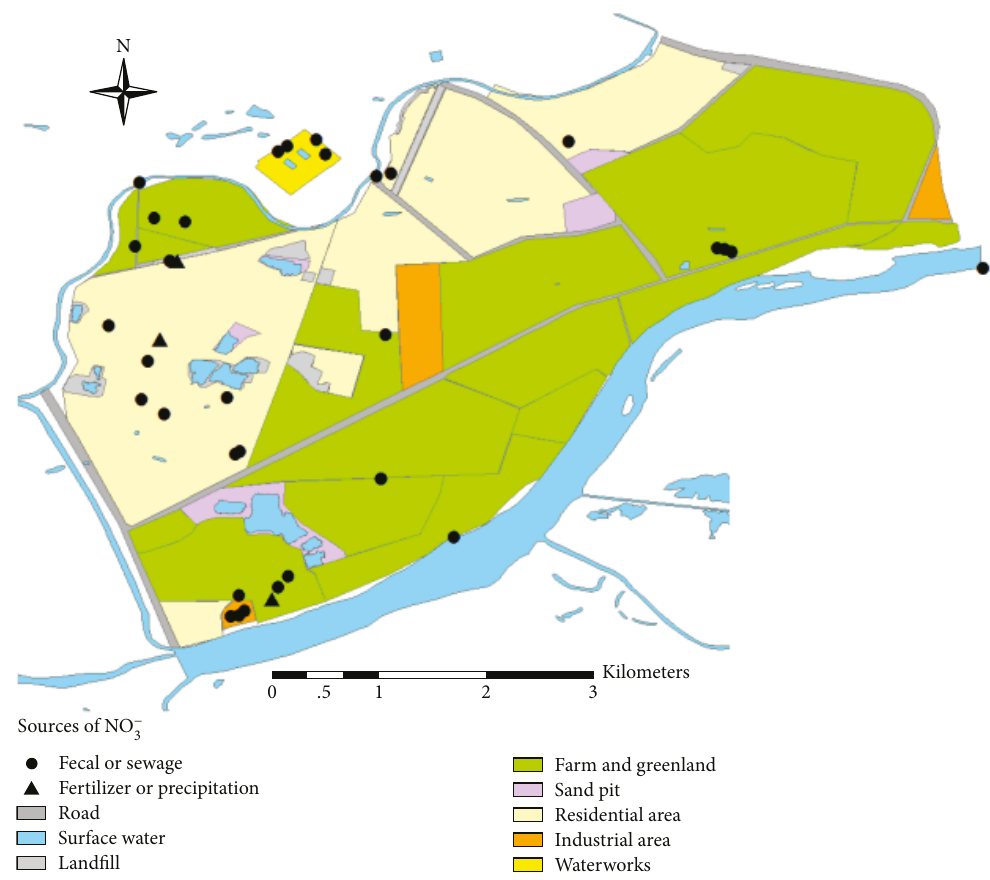
Figure 5: Nitrogen source spatial distribution in groundwater, September 2012.